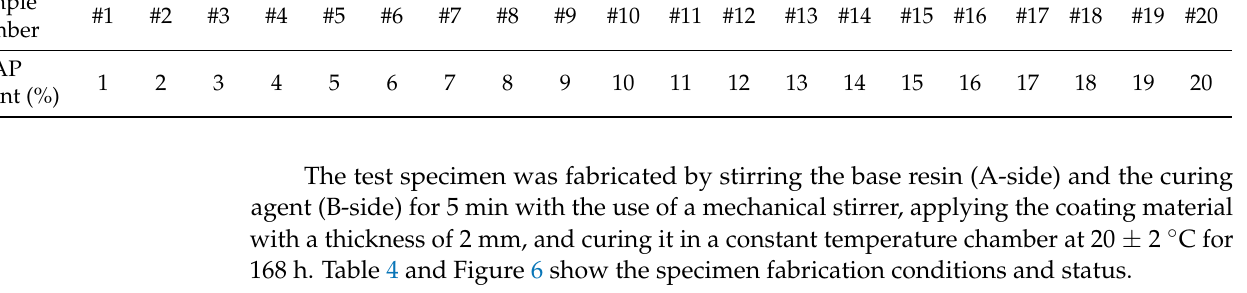
Table 4. The specimen fabrication conditions.